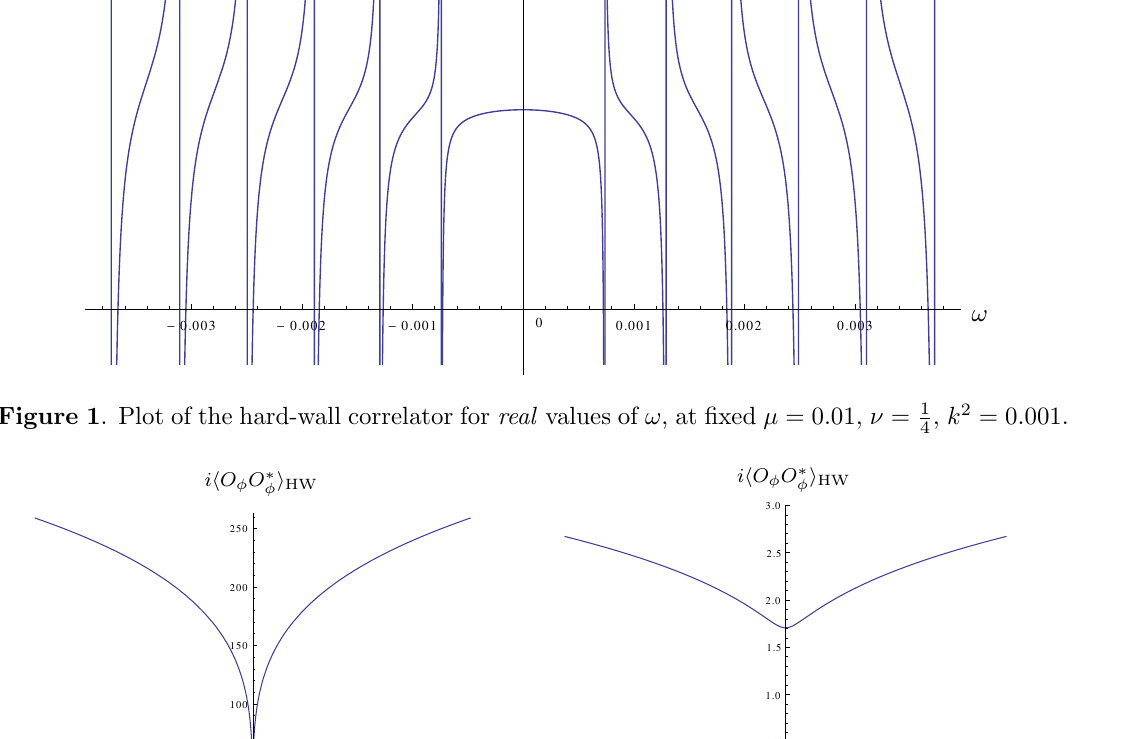
Figure 2 . Plot of the hard-wall correlator for purely imaginary values of ! , at (cid:12)xed (cid:22) = 0 : 01, (cid:23) = 1 , k 2 = 0 : 001. The second plot is a zoom close to the origin of the (cid:12)rst 4